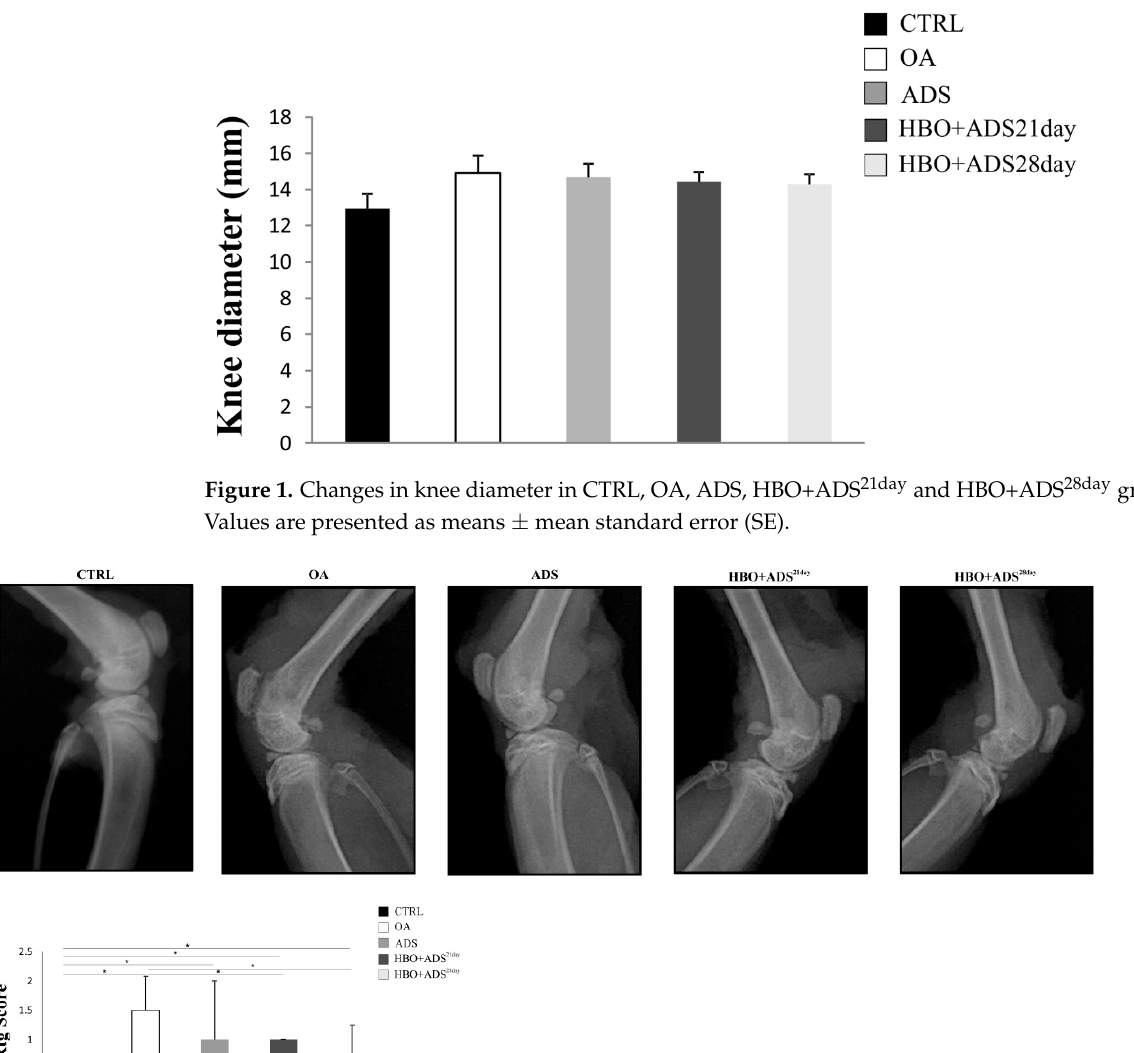
Figure 1. Changes in knee diameter in CTRL, OA, ADS, HBO+ADS 21day and HBO+ADS 28day groups. Values are presented as means ± mean standard error (SE).